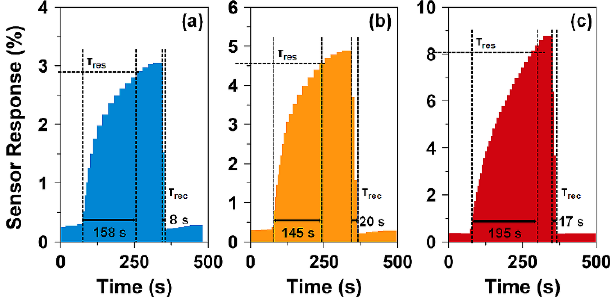
Figure 8. The response and recovery times of ZnFe 2 O 4 nanoparticles annealed at ( a ) 600, ( b ) 800, and ( c ) 1000 °C calculated from their respective responses to 300 ppm NO 2 .